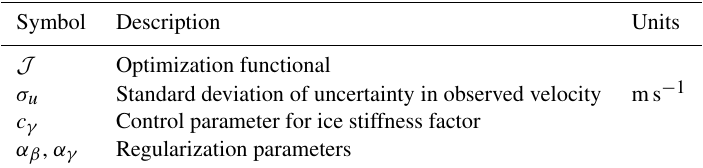
Table A7. Optimization variables and